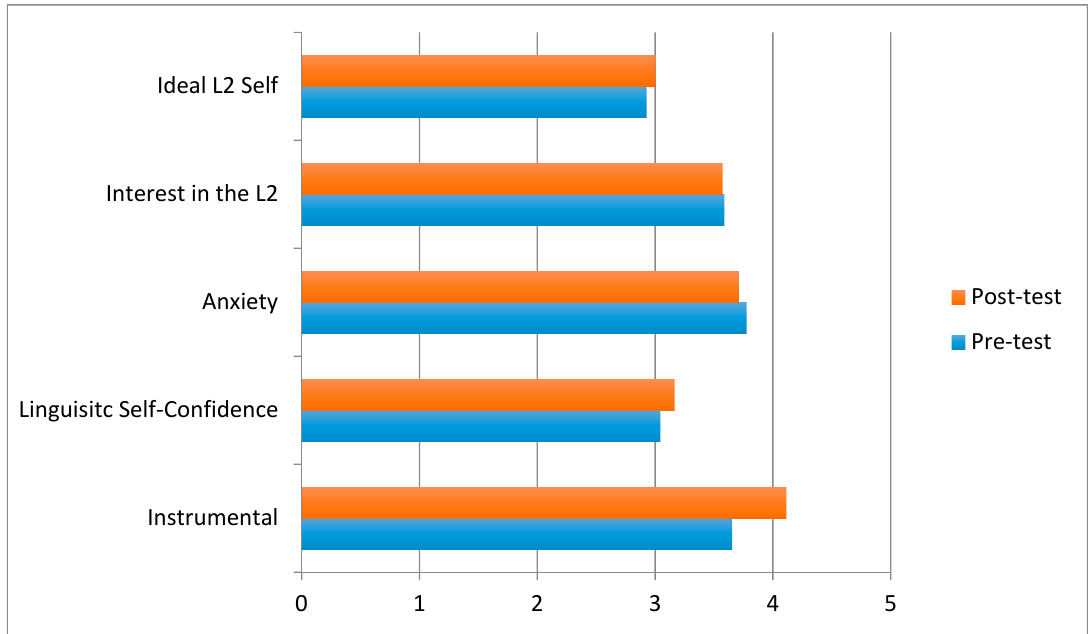
Figure 3. Pre- and post-test means by construct.